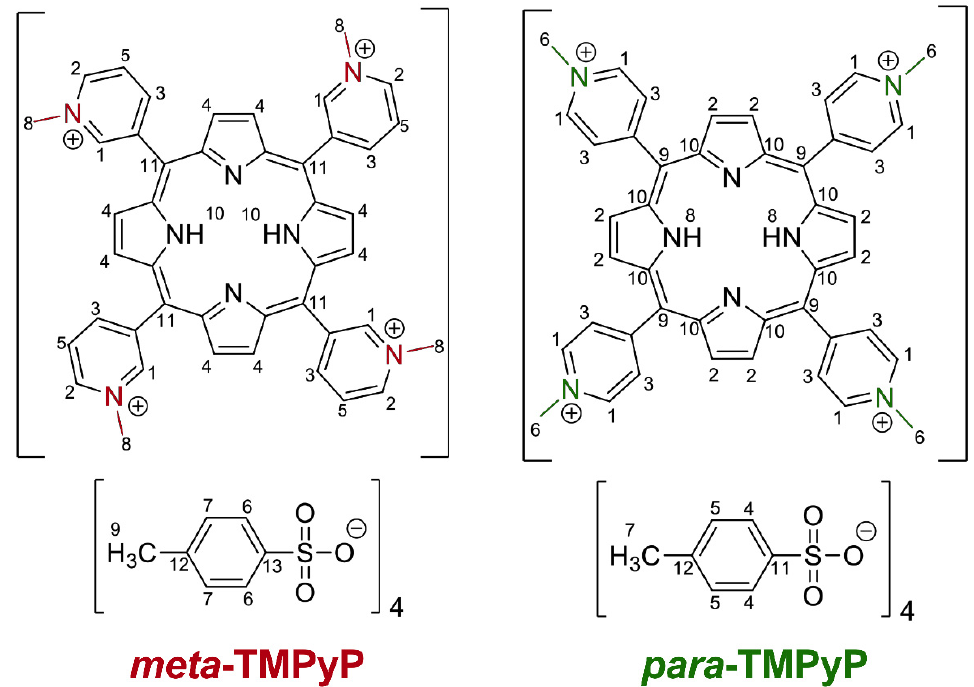
Figure 1. Chemical structures of (3,3 ′ ,3 ′ ’,3 ′ ’’-(5,10,15,20-tetrayl)tetrakis(1-methylpyridin-1- ium)porphyrin tetra-4-methylbenzenesulfonate (left, meta -TMPyP ) and of (4,4 ′ ,4 ′ ’,4 ′ ’’-(5,10,15,20- tetrayl)tetrakis(1-methylpyridin-1-ium)porphyrin tetra-4-methyl-benzenesulfonate (right, para